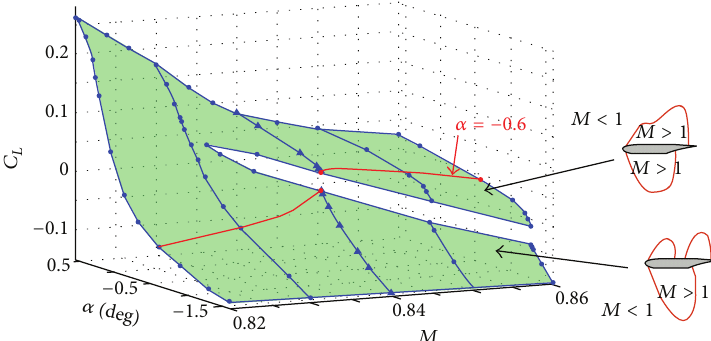
Figure 1: Lift coefficient 𝐶 𝐿 as a function of 𝑀 ∞ and the angle of attack 𝛼 for the 2D flow over J-78 airfoil (reproduced from [11] with permission). Sketches on the right illustrate the number of supersonic regions on the airfoil.